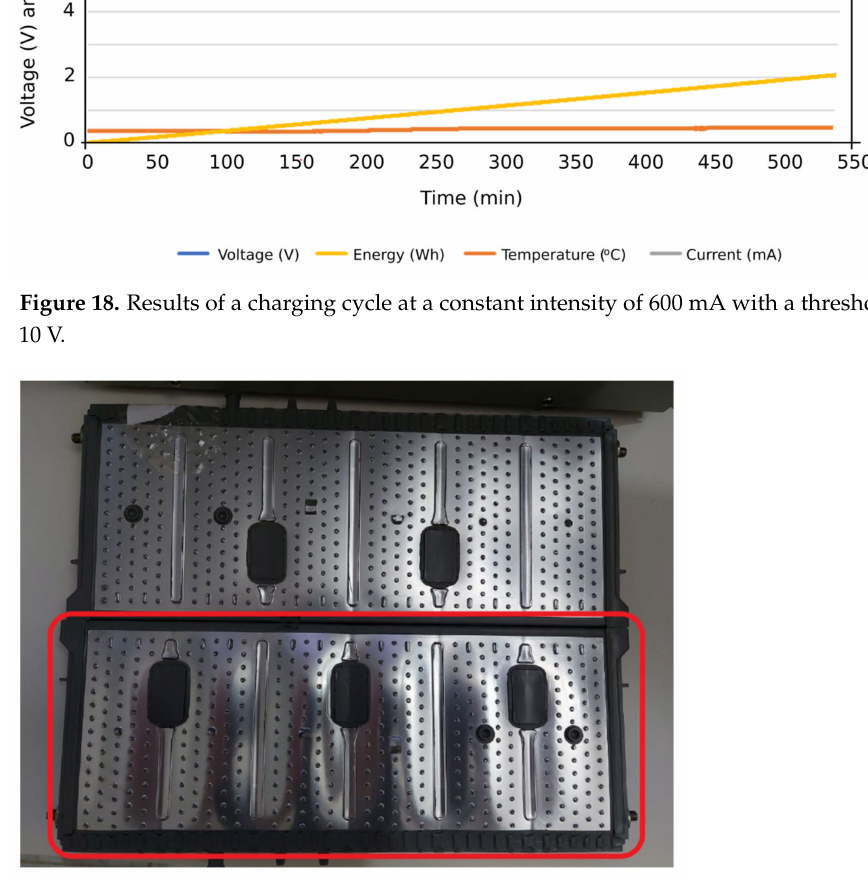
Figure 19. Comparison of two cells; the one below was deformed by an over-charge